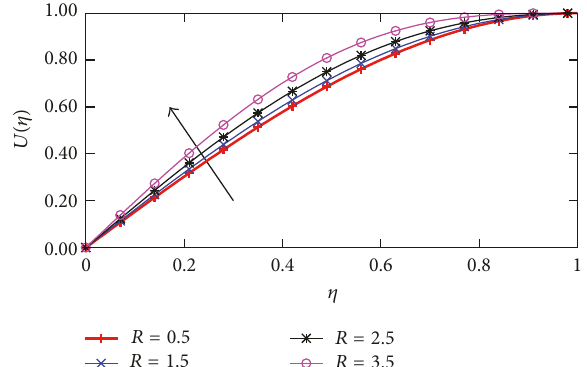
Figure 6: Effect of positive Reynolds number 𝑅 on the normal velocity.